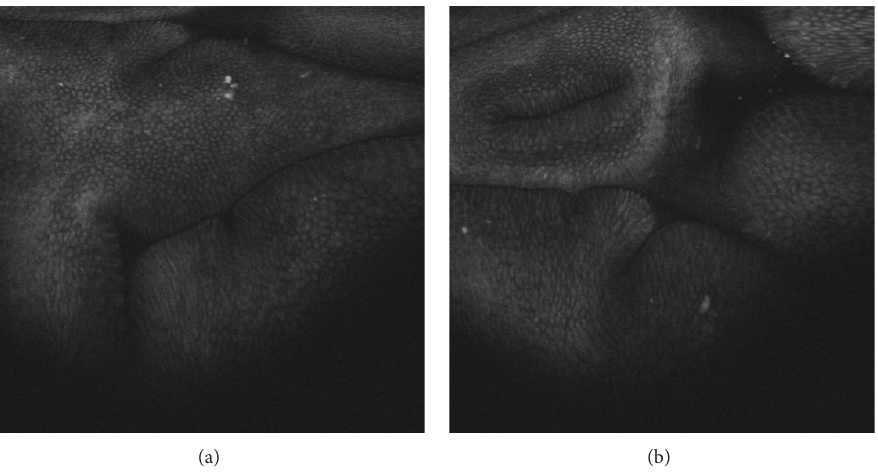
Figure 6: Stomach. Hyperplastic crypts in confocal laser endomicroscopy (original magnification 1000x).